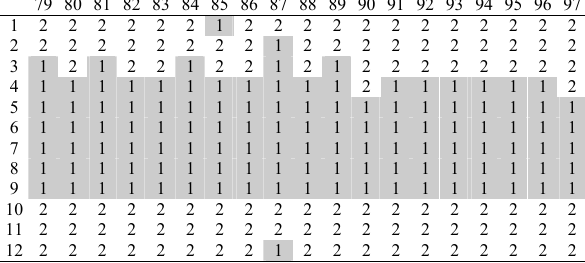
Fig. 2. Composite mean PV patterns (in PV units) for the NH types based on 2 rotated PCs of raw data. The outer circle is 20 ◦ N; the Greenwich meridian points to the left, 90 ◦ E downward, etc. Each type is identified by the number of corresponding PCs; its total fre- quency is given in parentheses.